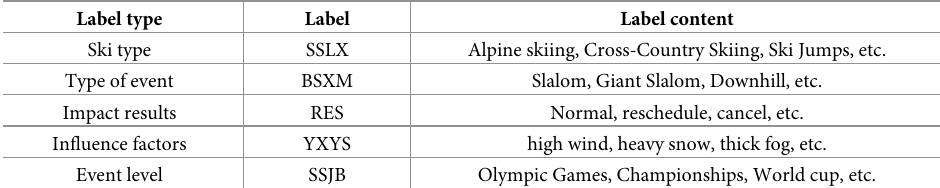
Table 3. Examples for the labels of a domain dictionary.